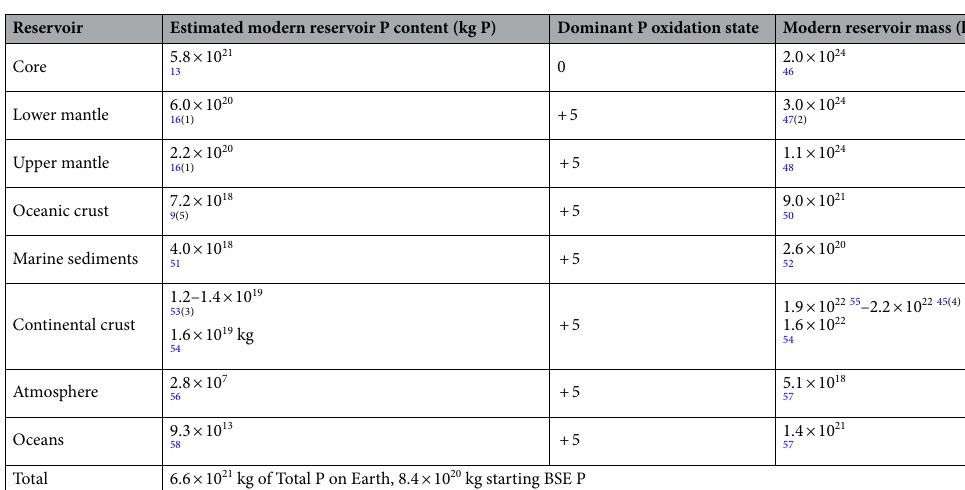
Table 1. Estimated P content of considered modern terrestrial reservoirs. Values are rounded to two significant figures. (1) Calculated assuming the 200 ppm UM P value cited in 16 . (2) Calculated from the mass of the mantle given in Lodders 47 minus the value estimated in 48 . (3) Computed using the range of CC masses cited and using the average 0.15 wt % P 2 O 5 value in 53 . (4) The total mass of Earth’s crust (oceanic + continental) is estimated as 2.8 × 10 22 kg 50 . Using crustal thickness to define CC, the mass of CC is 2.2 × 10 22 kg if the minimum thickness is 12–18 km, 2.1 × 10 22 kg for 22.5 km, 2.0 for 25 km, and 1.9 × 10 22 kg for 30 km. These numbers include all sediments as continental crust. Using the C2 definitions in 50 to distinguish OC and CC (and including oceanic plateaus which contain some CC), we calculate the CC mass as 1.9–2.2 × 10 22 kg. Using 2.8 × 10 22 kg as the value for the total mass of the crust and subtracting 1.9 × 10 22 kg as the mass of the CC leaves ~ 9 × 10 21 kg as the total mass of the OC, and, using the averaged 0.18% wt of P 2 O 5 in OC from 49 .